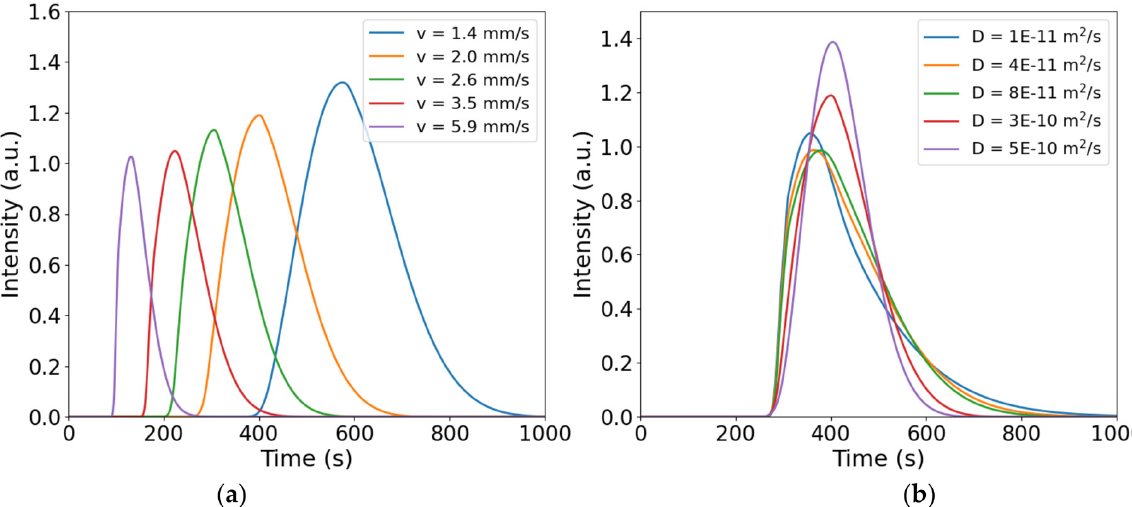
Figure 6. Simulated signals obtained in a channel having radius 0.375 mm and length 30 cm; ( a ) colors are associated with different values of flow velocity, while a constant diffusion coefficient of 3 × 10 − 10 m 2 /s is used; ( b ) colors are associated with different values of diffusion coefficient, while a constant flow velocity of 2 mm/s is